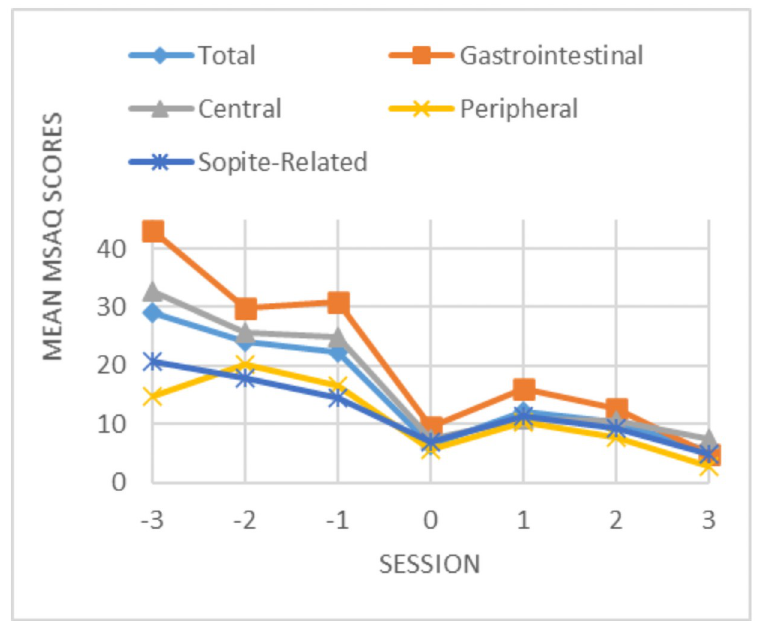
Fig 5. Average MSAQ score of all data for each